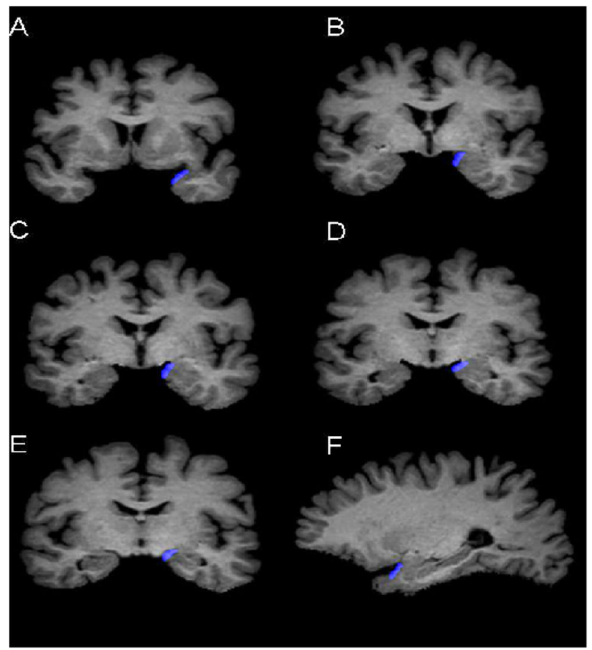
Figure 1. Delineation of the piriform-cortical amygdala (PCA). Sample views of the PCA (in blue) at different coronal levels (A-E) and a sagittal level (F). Sagittal views were automatically reconstructed synchronously when the delineation was performed on consecutive coronal